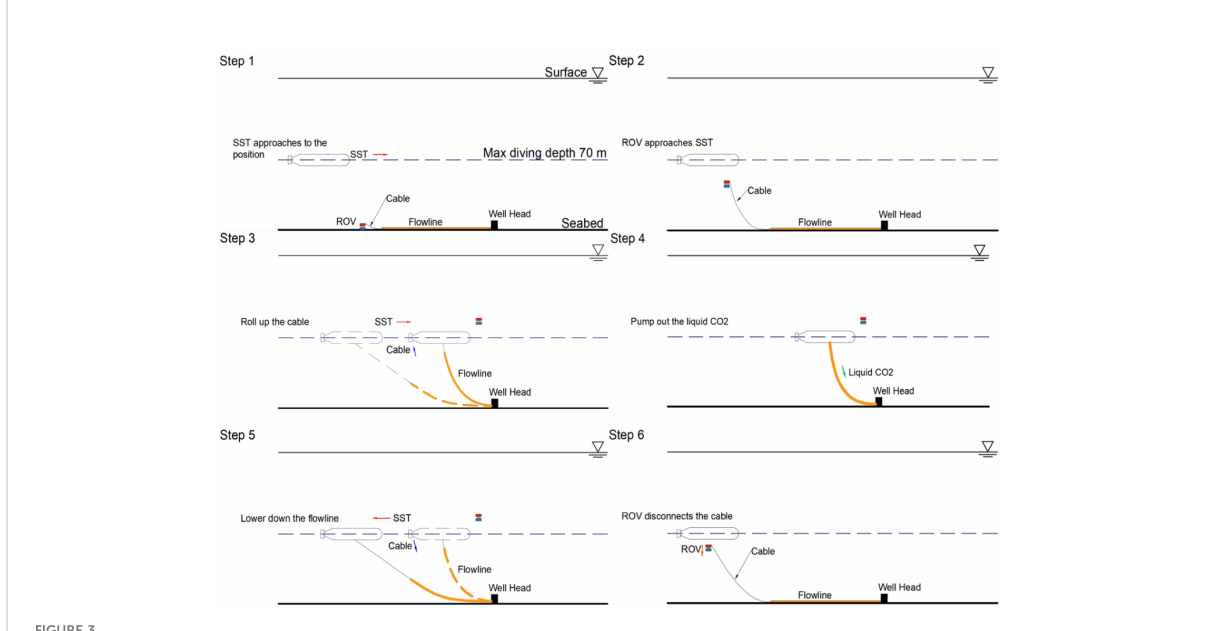
FIGURE 3 Flowline connecting and disassembly